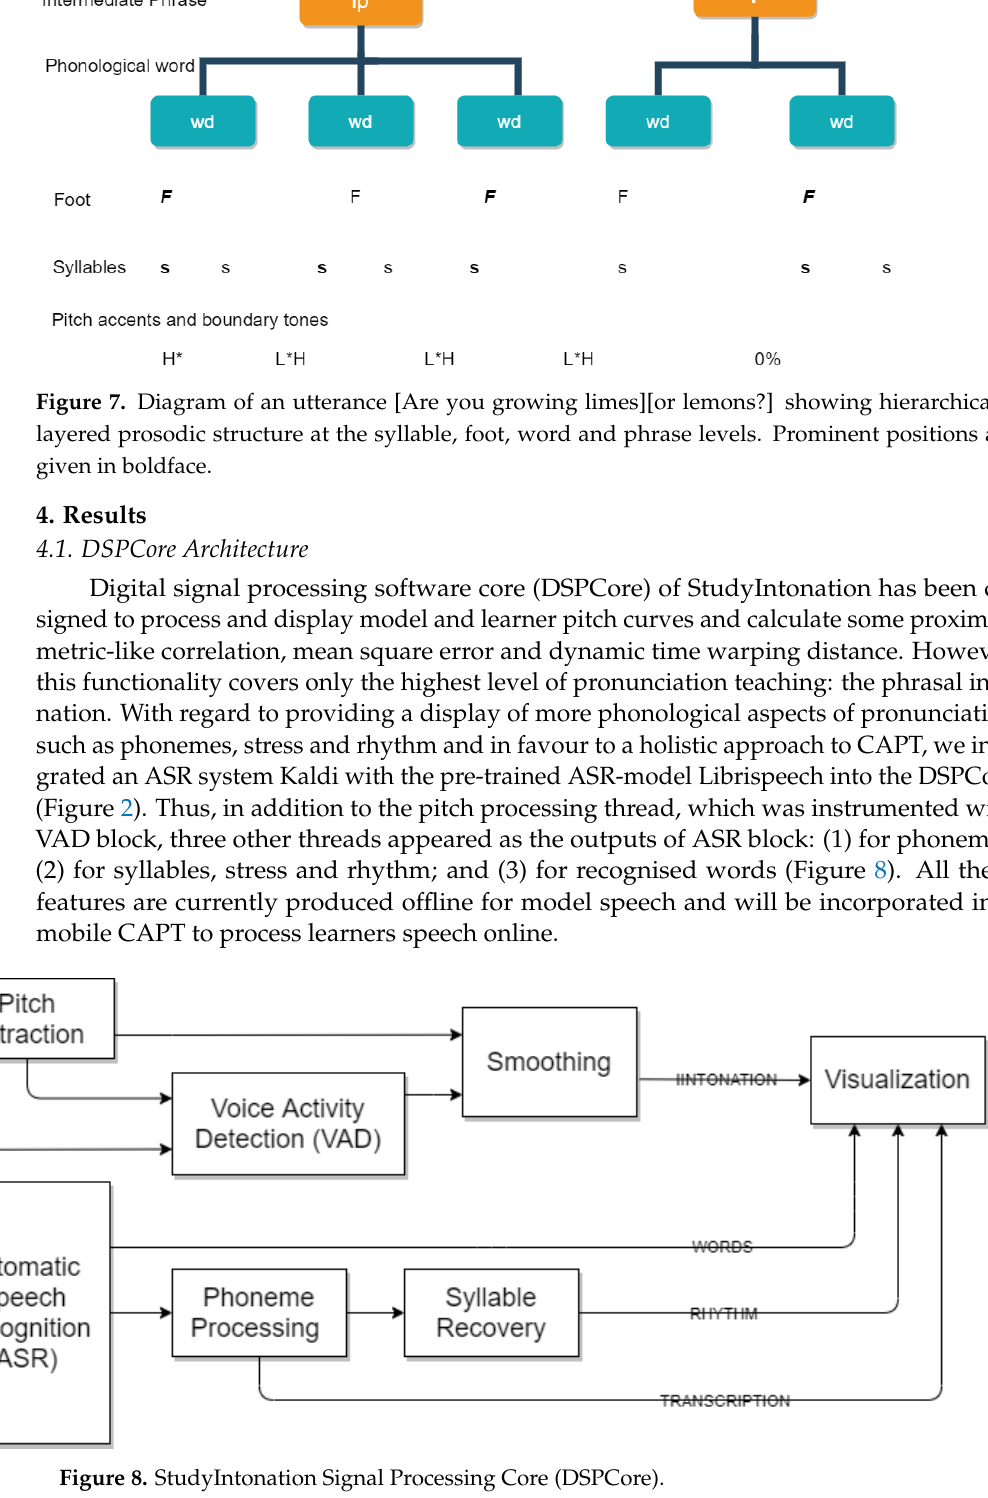
Figure 8. StudyIntonation Signal Processing Core